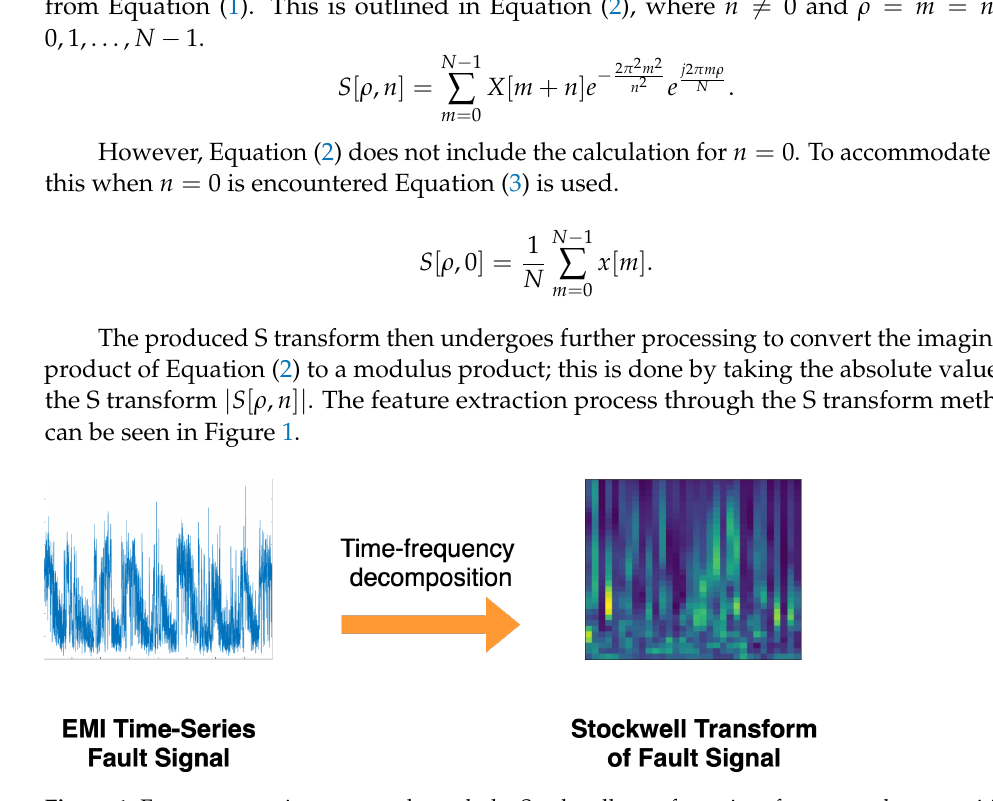
Figure 1. Feature extraction process through the Stockwell transform time-frequency